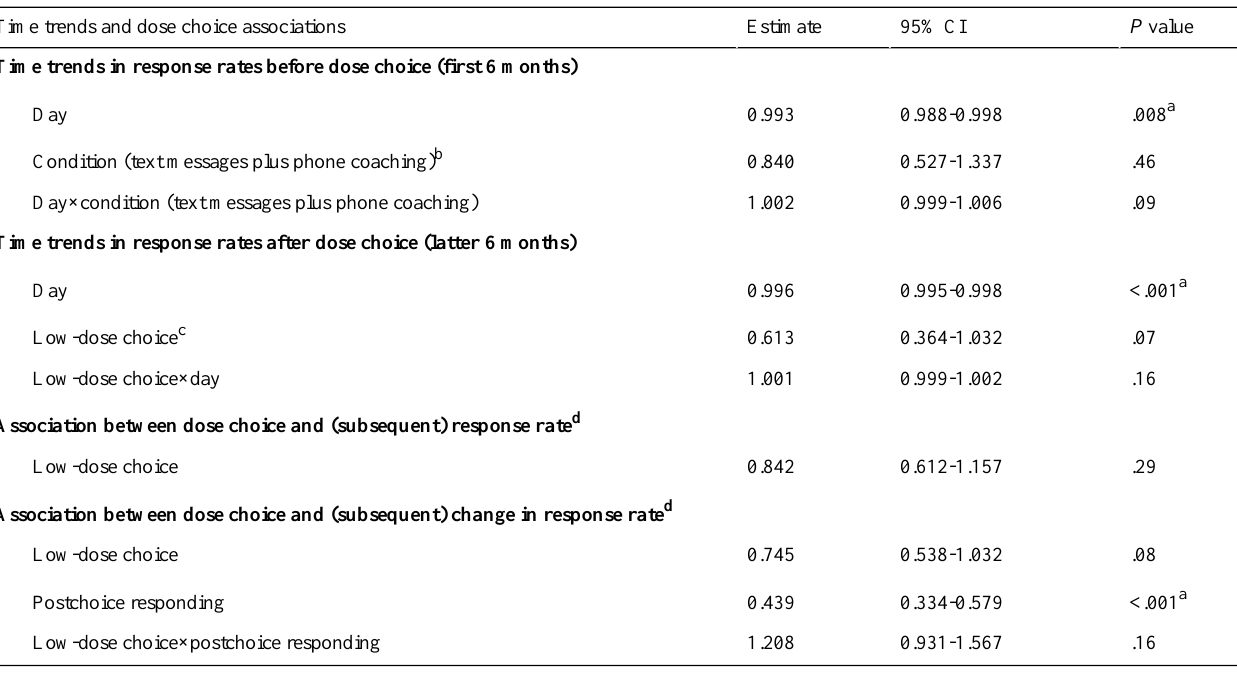
Table 2. Results for logistic regression models examining time trends in